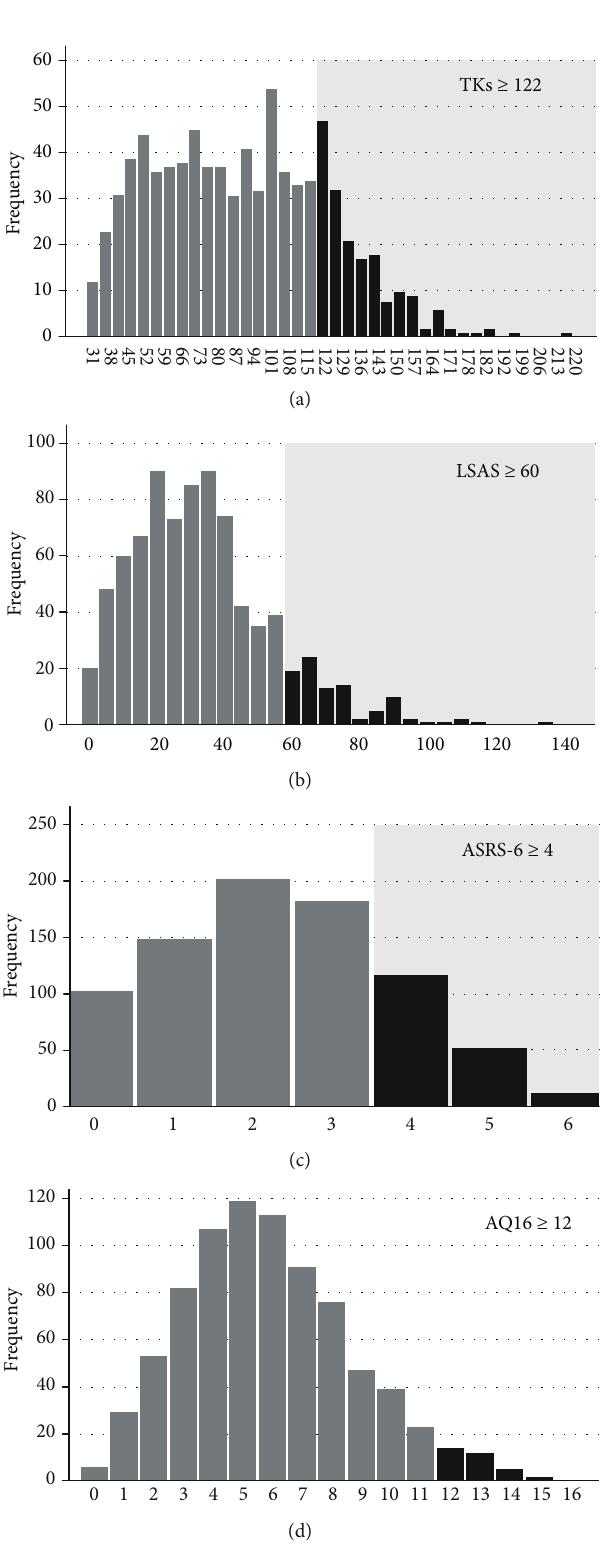
Figure 1: Histograms of the psychological test scores. The horizontal axes indicate the scores for each test. The vertical axes indicate the number of participants (frequency) with each score. The gray area indicates participants whose scores exceeded the cut-o ff value (COV). (a) Distribution of the Taijin-Kyofu-sho scale (TKs) scores. COV: 122. (b) Distribution of the Liebowitz Social Anxiety Scale (LSAS) scores. COV: 60. (c) Distribution of the adult Attention-De fi cit/Hyperactivity Disorder Self-Report Scale-6 (ASRS-6) scores. COV: 4. (d) Distribution of the 16-item Autism-Spectrum Quotient (AQ16) scores. COV: